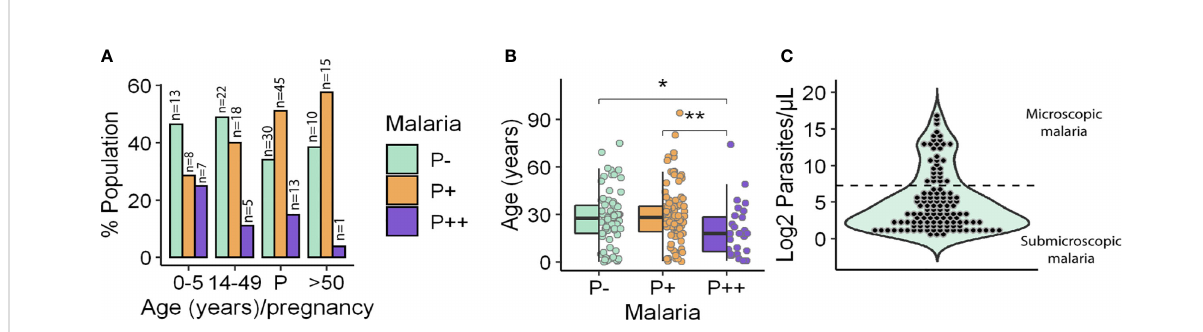
FIGURE 1 Participant distribution by age and parasitemia. (A) Frequency of microscopic (P++), submicroscopic (P+) malaria infections and uninfected people (P − ) by age and pregnancy (P) groups. (B) Age of individuals by parasitemia group. Box hinges indicate 25th and 75th percentiles, and the whiskers extend to hinges ± 1.5*IQR. Signi fi cant differences obtained by unpaired Wilcoxon rank-sum test are indicated. *P ≤ 0.05; **P ≤ 0.01. (C) Population distribution according to the log 2 of parasitemia. Microscopic (up) and submicroscopic (down) infections are separated by a dotted line. Parasitemia was measured as parasites/µl.